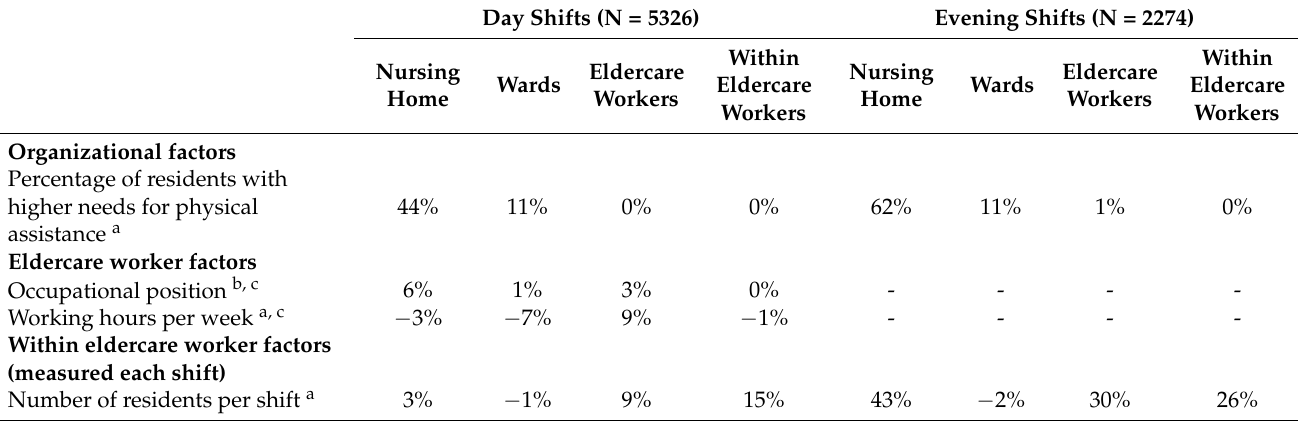
Table 5. Percentage change to the total variability in resident handlings per shift (at each level), due to the inclusion of specific factors.